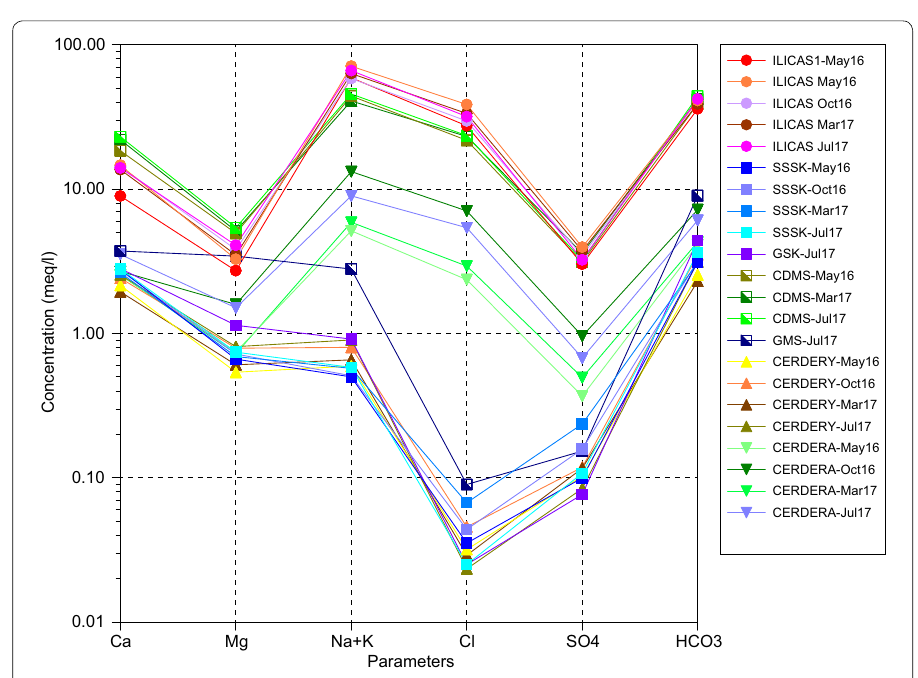
Fig. 8 Schoeller diagram indicating ionic concentrations of waters in the study